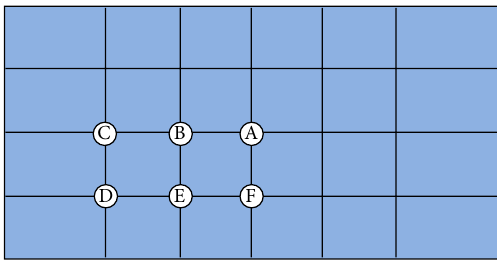
Figure 4: Layout of measuring points.